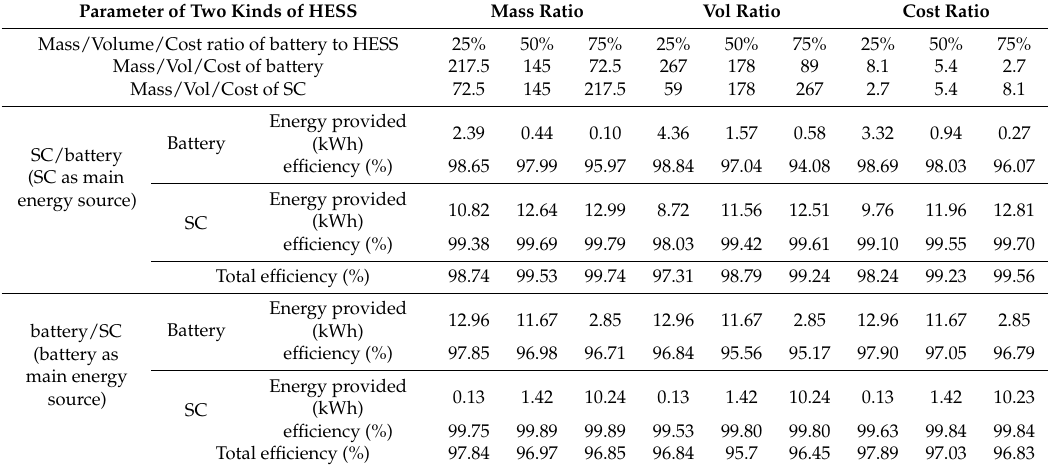
Table 8. Comparison of two configurations by different ratios of mass/vol/cost. Parameter of Two Kinds of